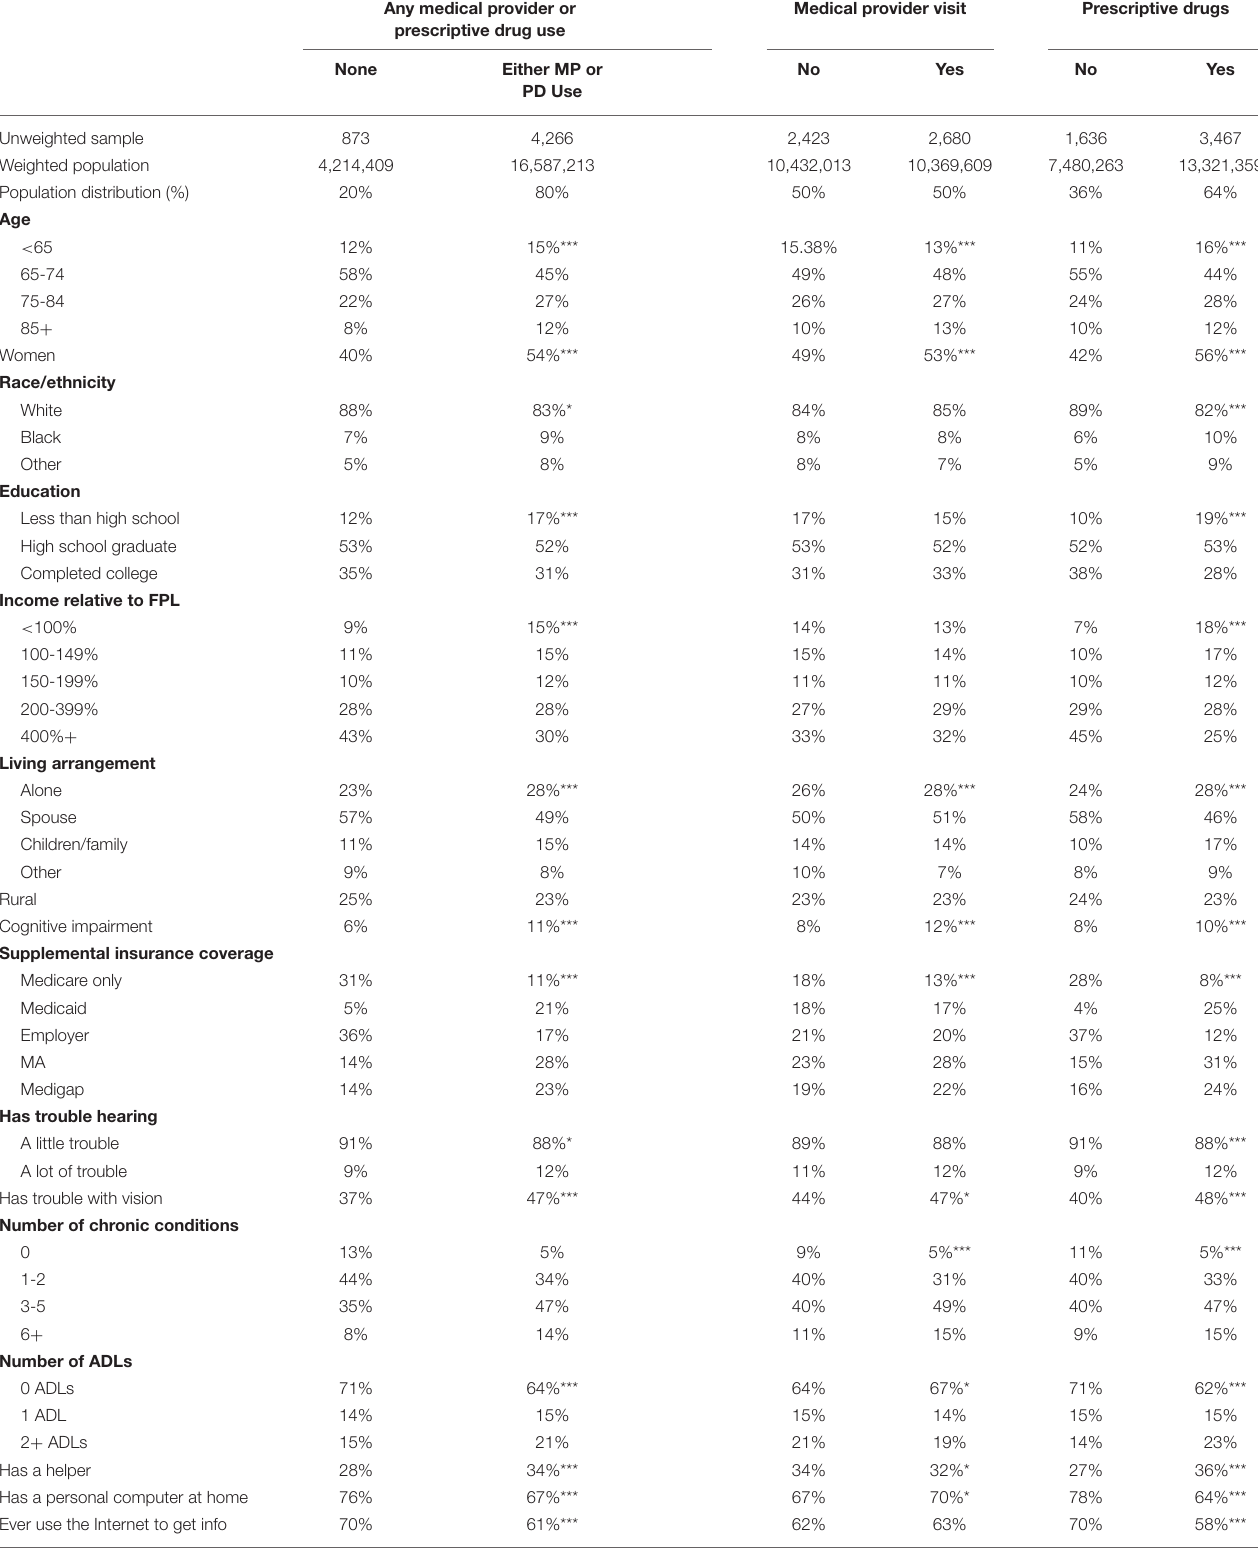
Medical provider